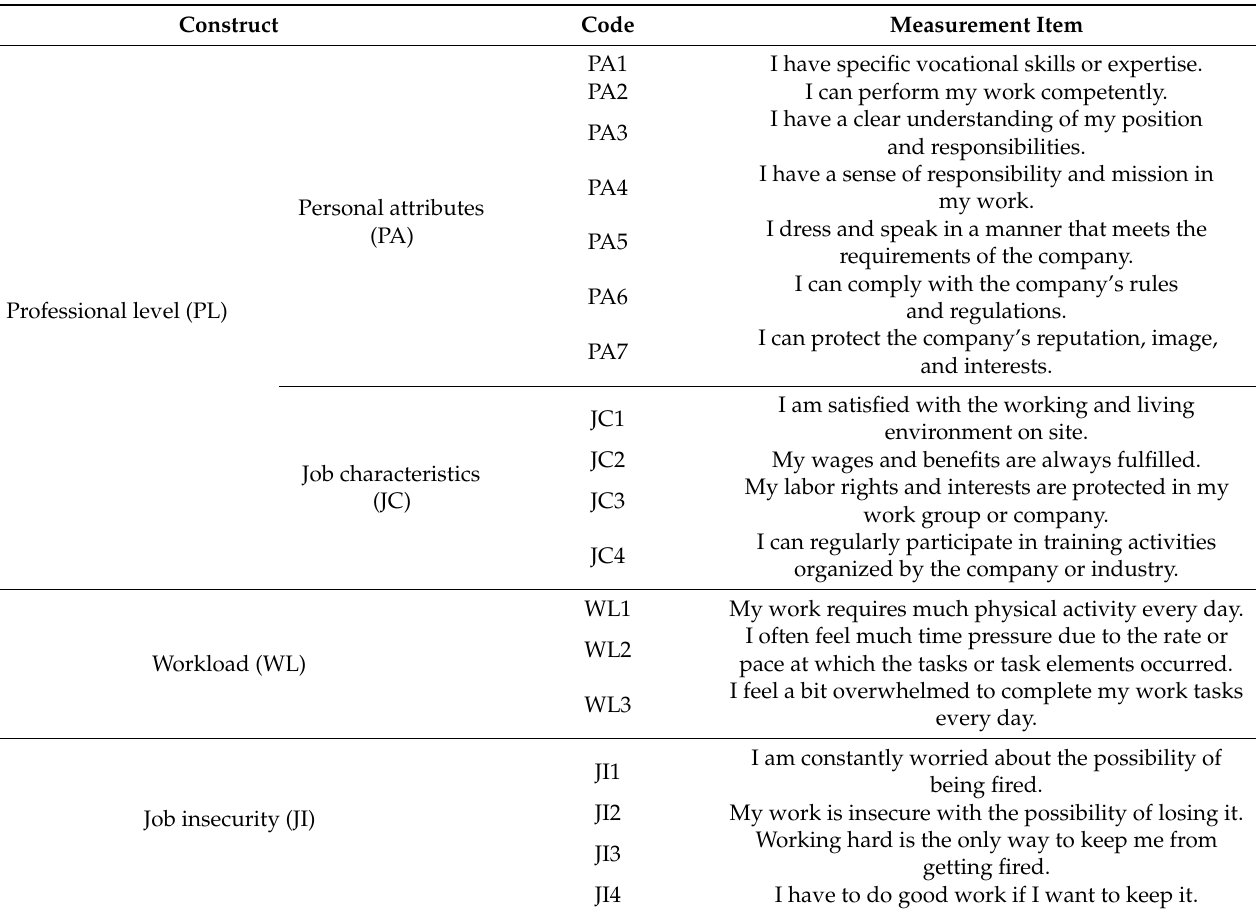
Table A1. Questionnaire items in measurement